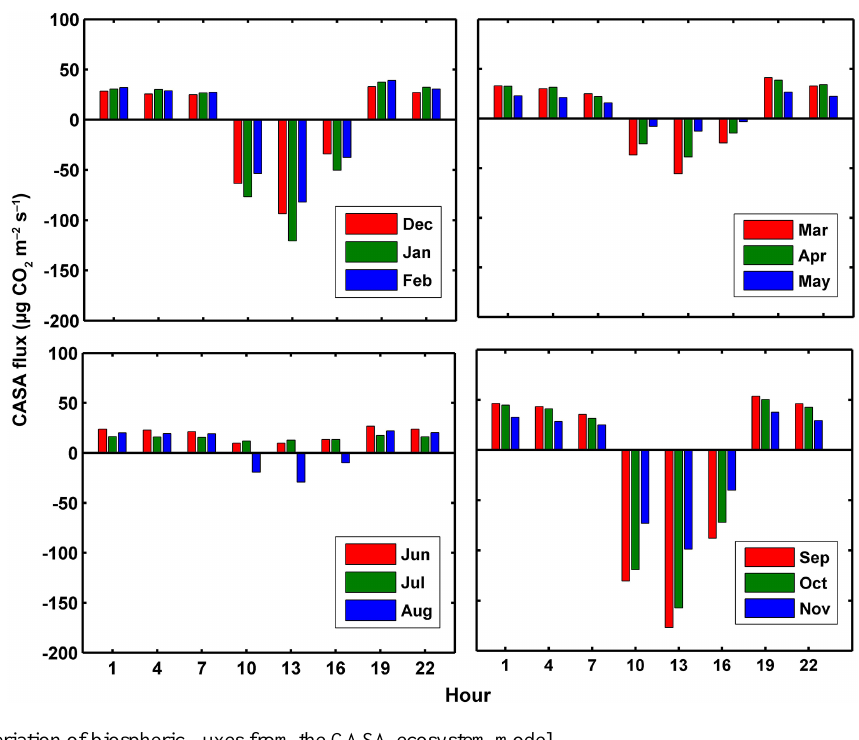
Figure 10. Diurnal variation of biospheric fluxes from the CASA ecosystem model.